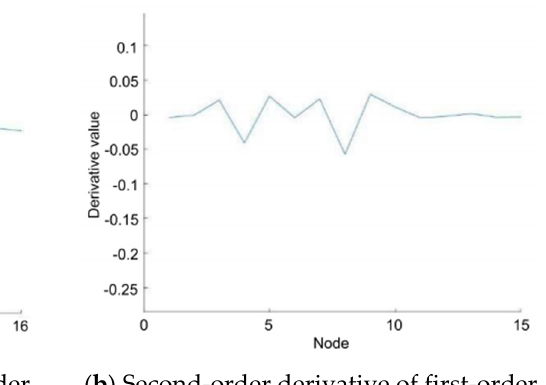
Figure 19. First-order and second-order derivative curves of the differences of the first five orders of modes under Conditions 5 and 7.